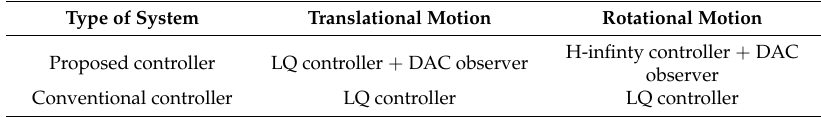
Table 1. System configuration.